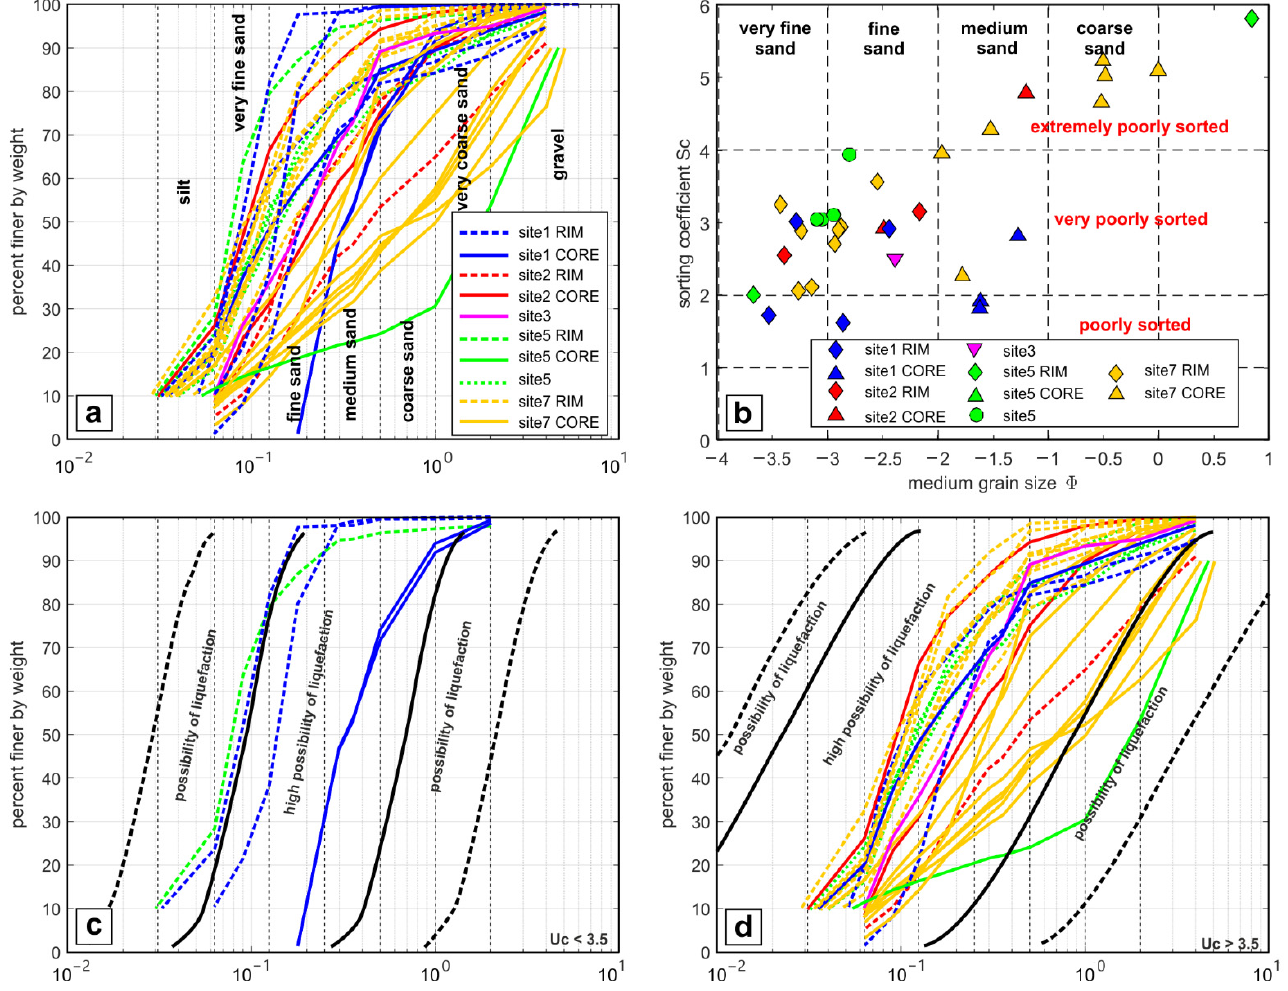
Figure 2. ( a ) Cumulative diagram of the grain size of the collected samples. ( b ) Scatter plot of Cs vs. D50. Cumulative diagram of the grain size of the collected samples with a Uc < 3.5 ( c ) and a Uc > 3.5 ( d ), modified after [14].